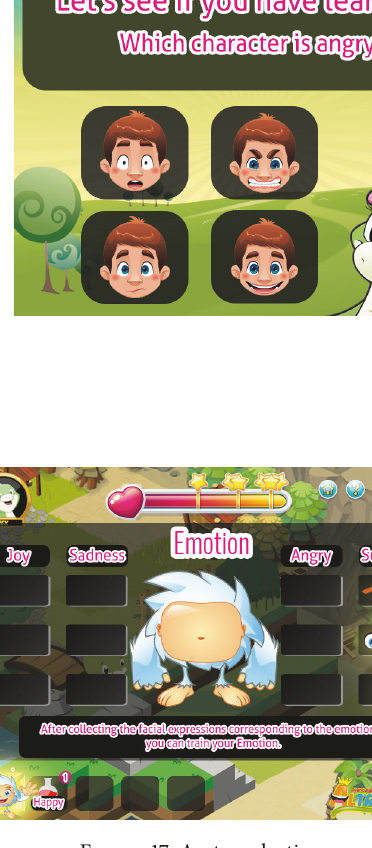
Figure 19: Selected expressions.